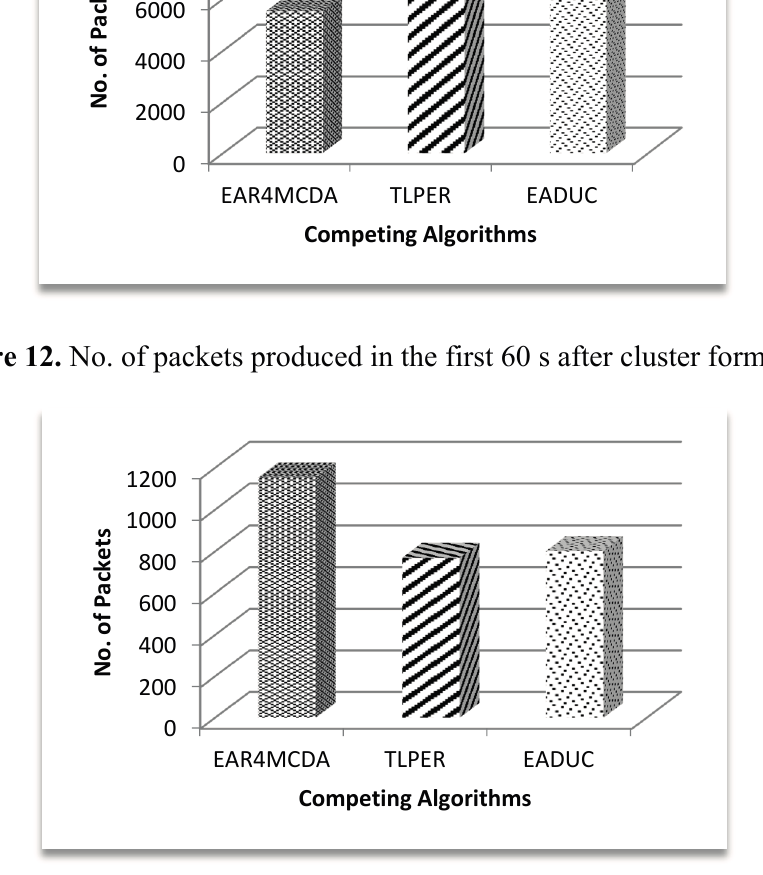
Figure 13. Throughput in first 300